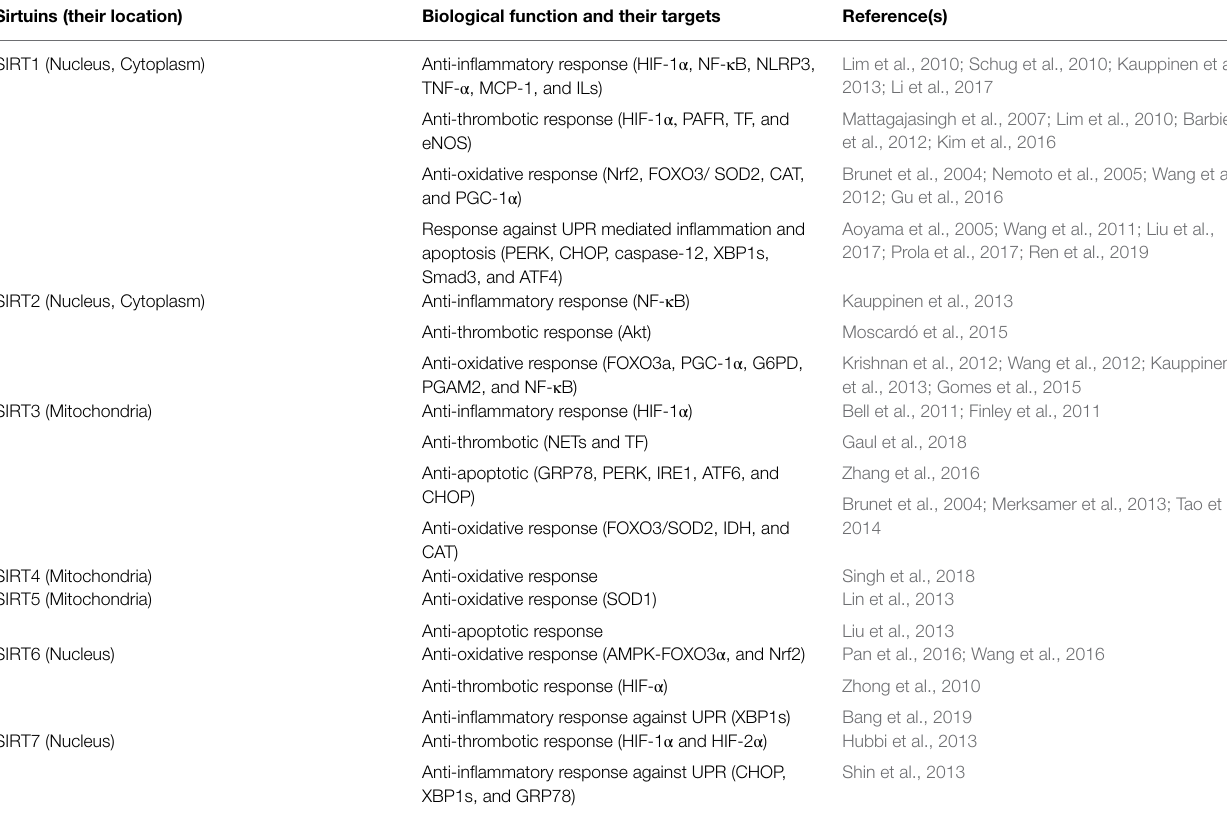
TABLE 1 | Sirtuins and their biological functions in hypoxia induced oxidative stress, inflammation, thrombosis, and apoptosis. Sirtuins (their